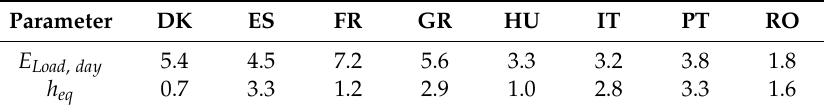
Table 7. Input data for the design of the SHSs in several